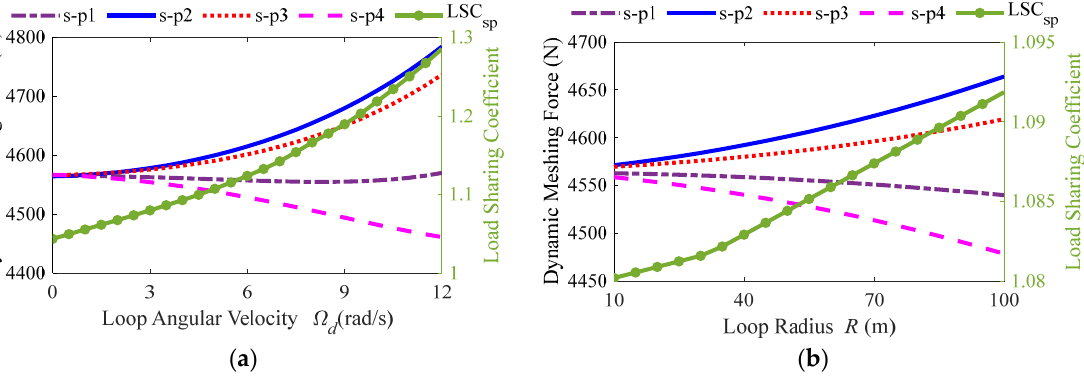
Figure 17. LSC and dynamic meshing force mean versus different loop motion parameters. ( a ) At different LAV; ( b ) At different LR.